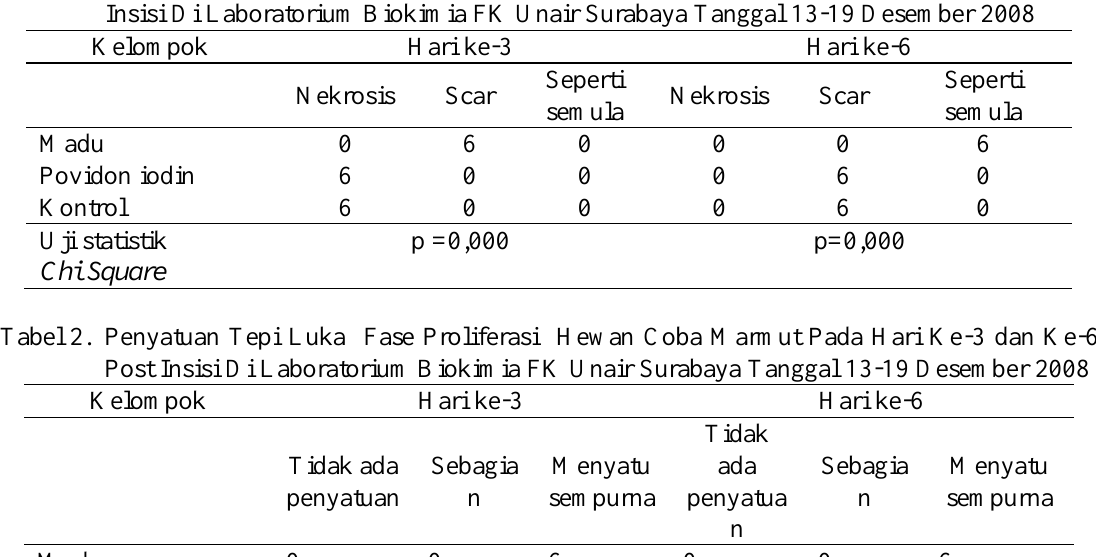
Tabel 1. Granulasi Pada Fase Proliferasi Hewan Coba Marmut Pada Hari Ke-3 dan Ke-6